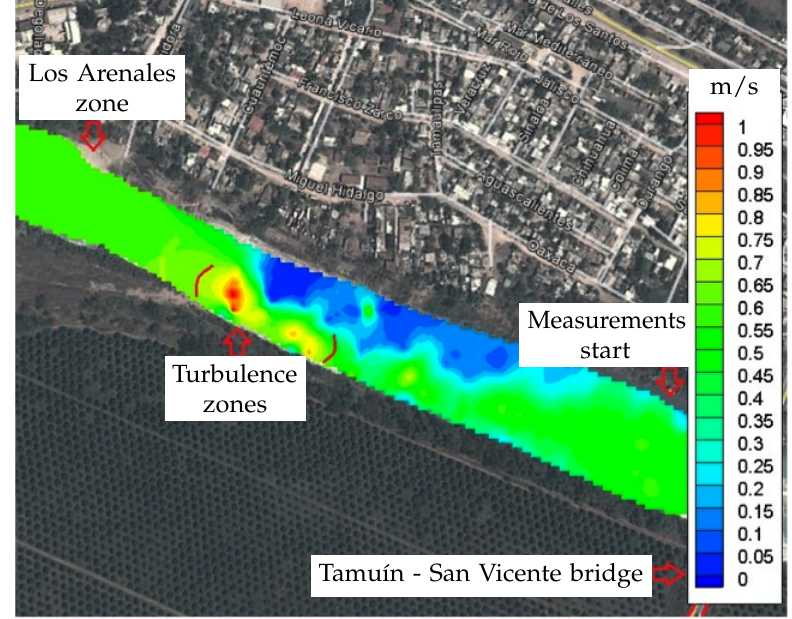
Figure 6. Magnitude of the measured water flow